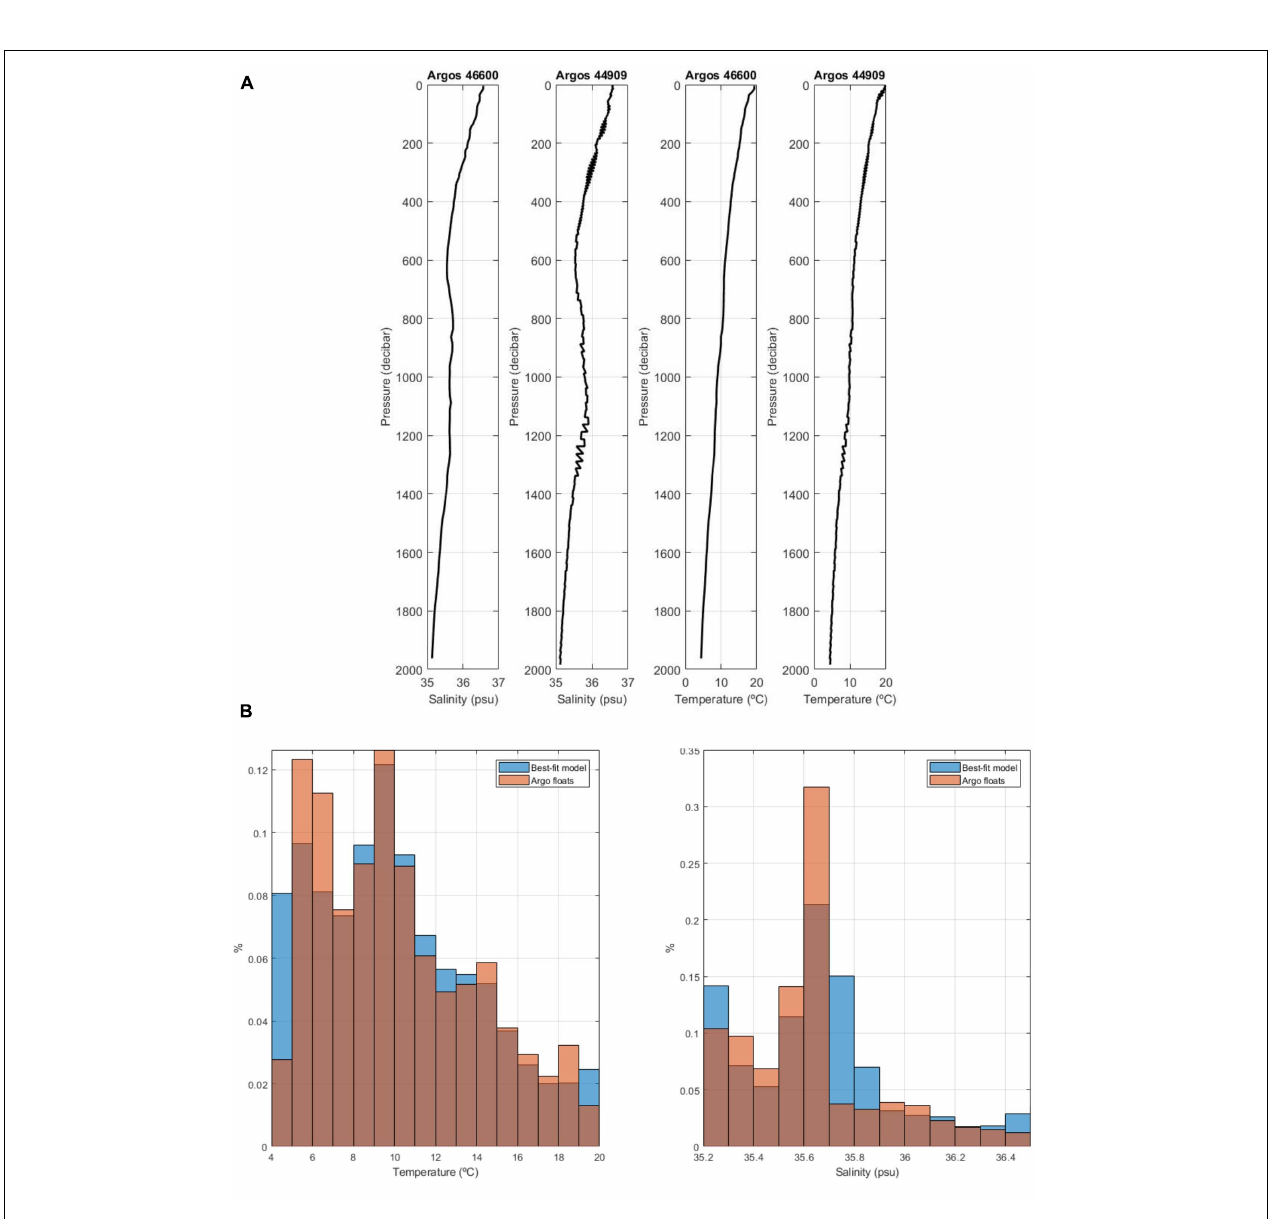
FIGURE 4 | (A) ARGO profiles showing the measured temperature and salinity vs. pressure. (B) Comparison between histograms inferred from the temperature and salinity measured by the ARGO floats and the best-fit inverse